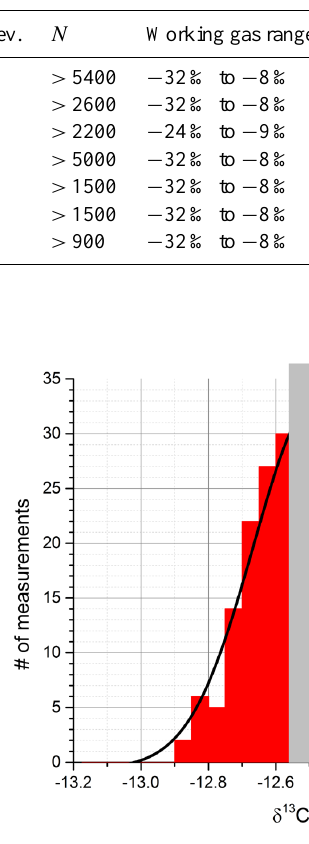
Fig. 7. Histogram of long-term target (LTG-48A) values between November 2011 and May 2012 from (four consecutive) measure- ments once per week in red and the IRMS value for LTG-48A in